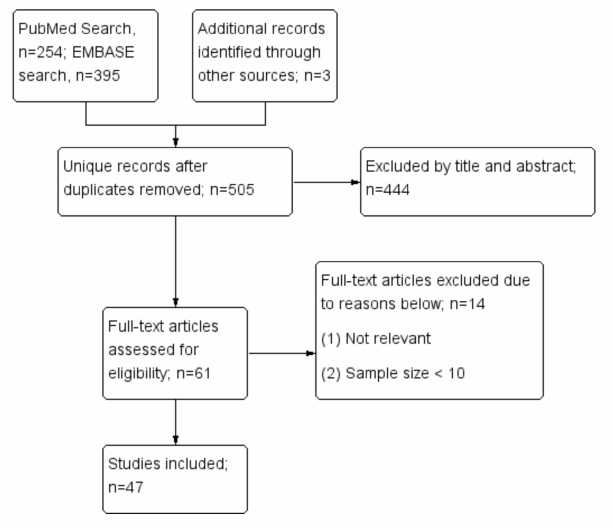
Figure 1. Flow diagram based on the Preferred Reporting Items for Systematic Reviews and Meta- Analyses (PRISMA)